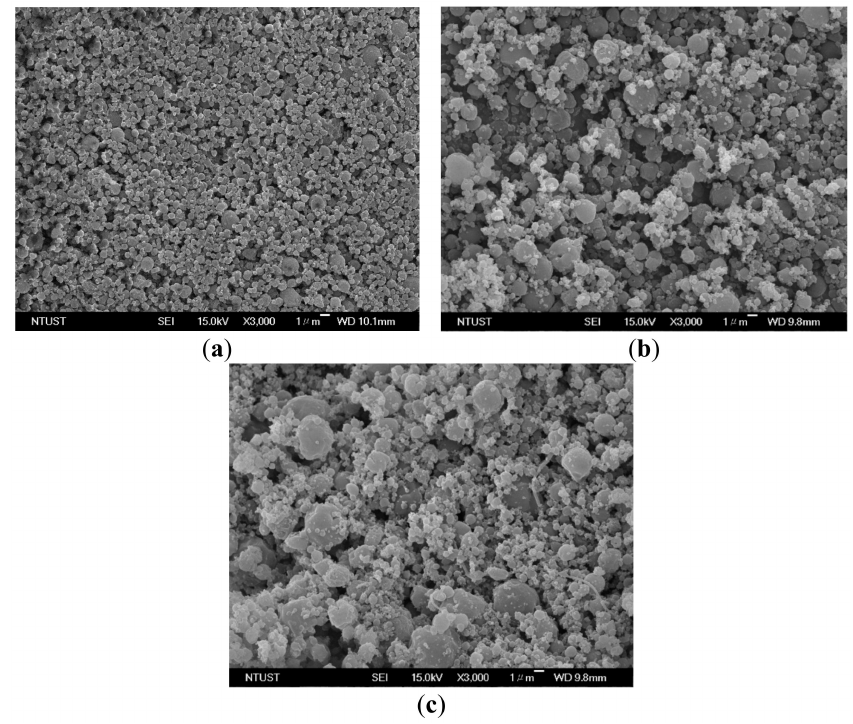
Figure 8. FESEM images of PEG particles produced by the LTSAA process at di ff erent molecular weights of PEG ( MW ): ( a ) MW = 4000, ( b ) MW = 6000, ( c ) MW = 10,000.